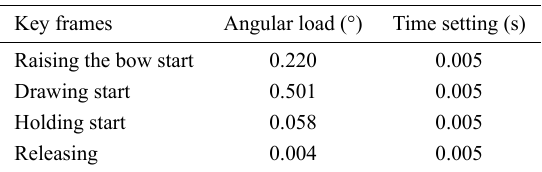
Table 2. Material parameters of the shoulder finite element model.